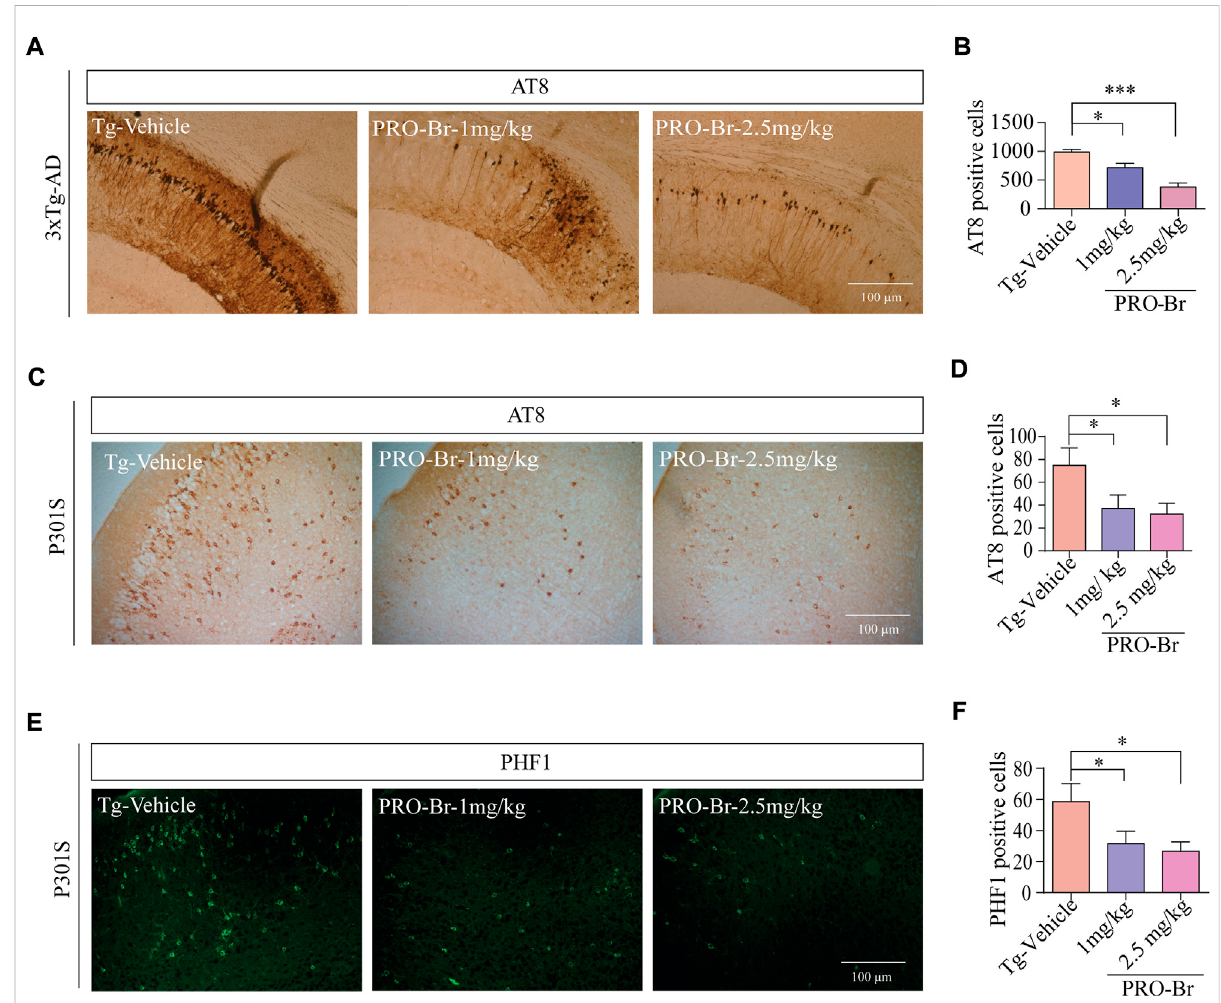
FIGURE 4 Immunohistochemical analysis of brain tissues of PRO-Br-treated AD mice. Images of brain tissue slices showing that PRO-Br reduces (A-B) AT8-positive cells in 3xTg-AD mice and also reduced AT8-and PHF1-positive cells in (C-F) P301S tau mice dose-dependently. Data was quanti fi ed using ImageJ software, * p < 0.05 and *** p <